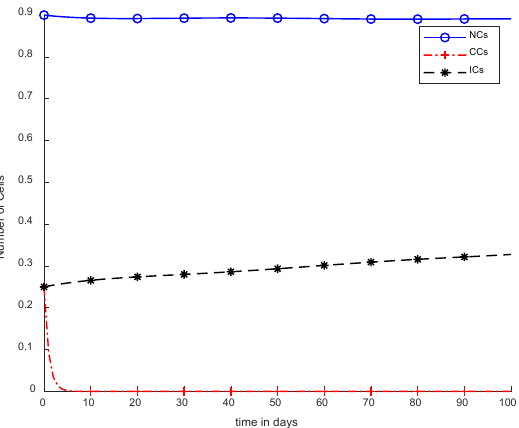
Figure 8. With chemotherapy at a continuous dose and SMC to kill CCs.